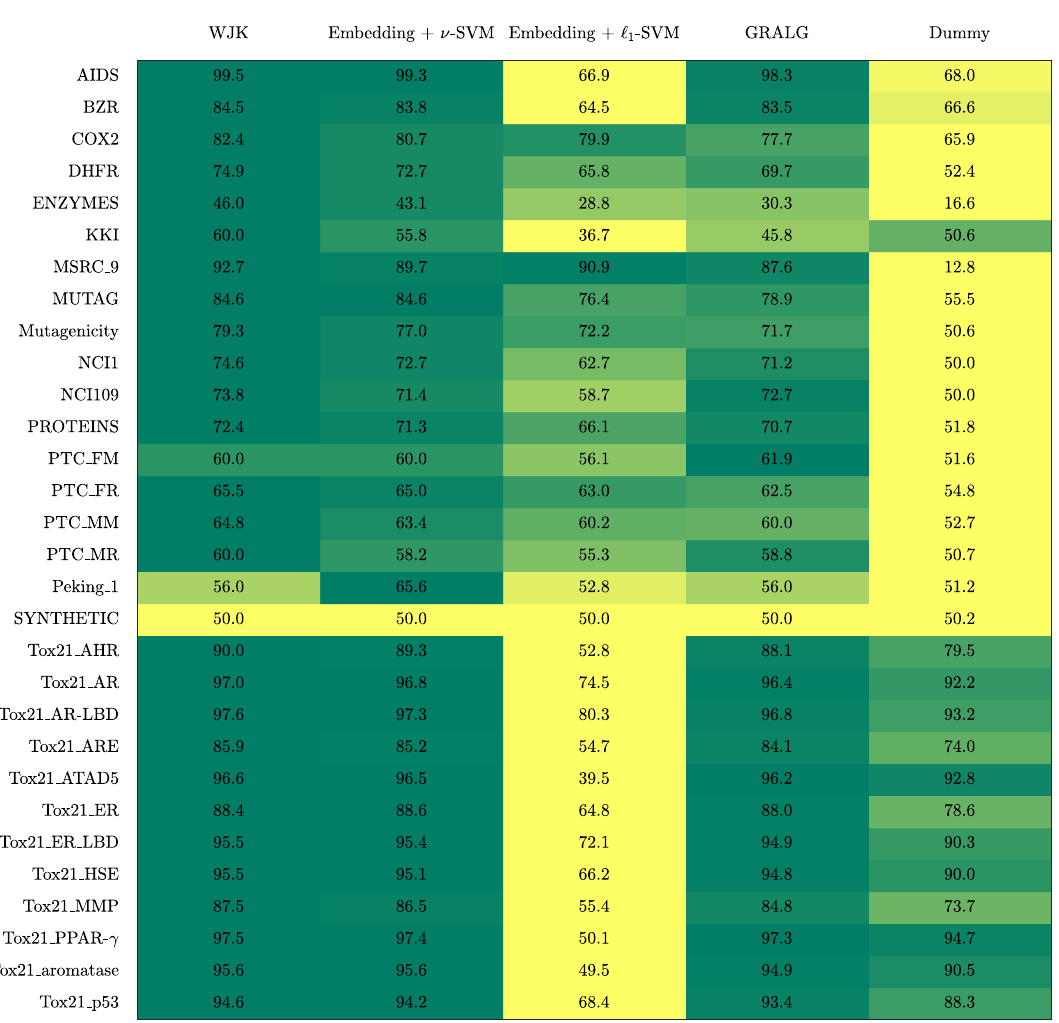
Figure 1. Average accuracy on the test set amongst the dummy classifier, GRALG, WJK and the proposed embedding technique. Results are given in percentage. The colour scale has been normalised row-wise (i.e., for each dataset) from yellow (lower values) towards green (higher values,